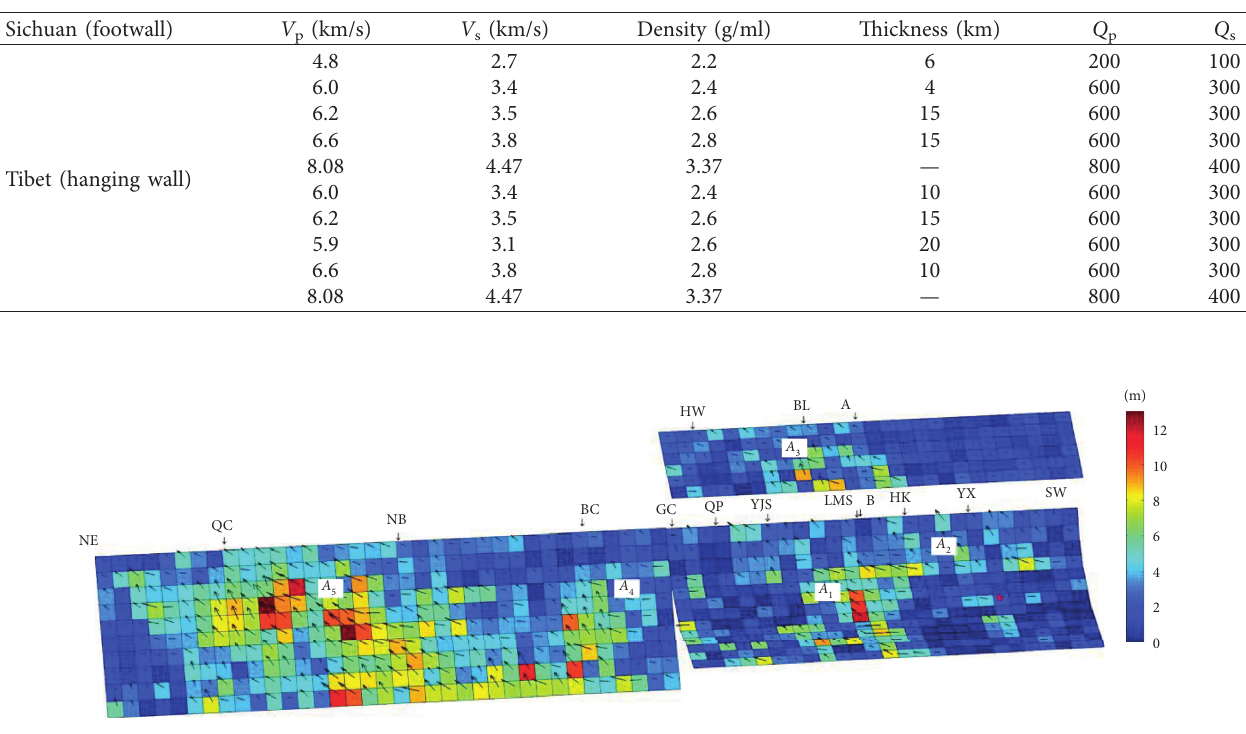
Figure 5: The slip distribution based on the joint inversion of teleseismic and strong-motion